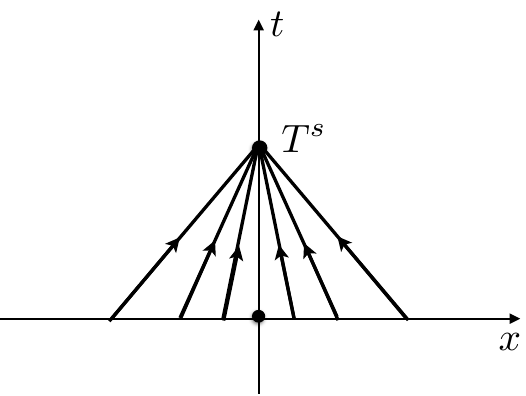
Figure 2 . Characteristics of PPF for the initial velocity pro(cid:12)le (3.14). All characteristics cross at the same time t = T s forming the so called perfect